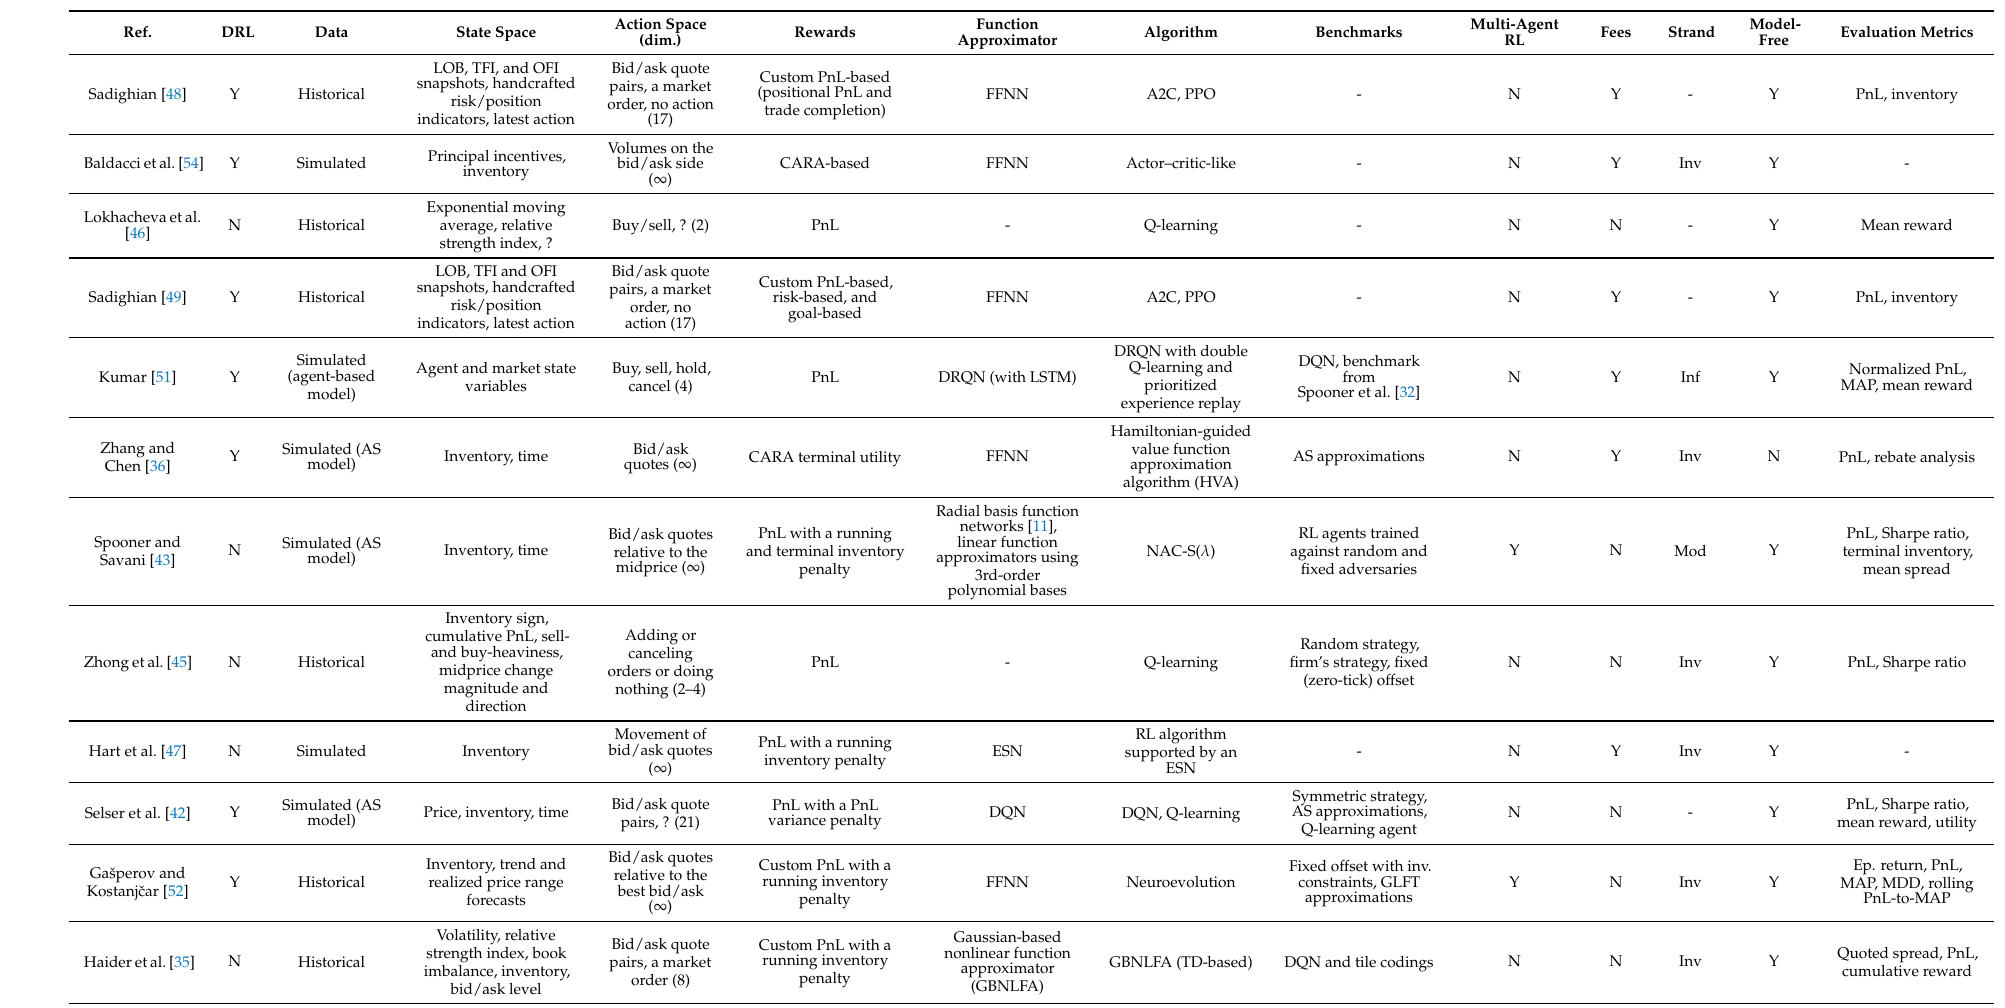
Gaussian-based Bid/ask quote Custom PnL with a nonlinear function running inventory pairs, a market GBNLFA (TD-based) DQN and tile codings N N Inv Y Quoted spread, PnL, cumulative approximator penalty order (8) (GBNLFA)